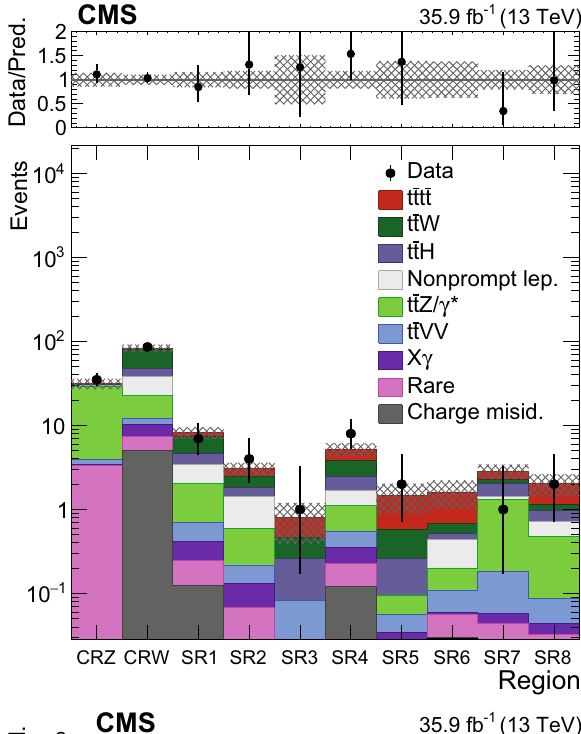
Table 4 The post-fit background, signal, and total yields with their total uncertainties and the observed number of events in the control and signal regions in data